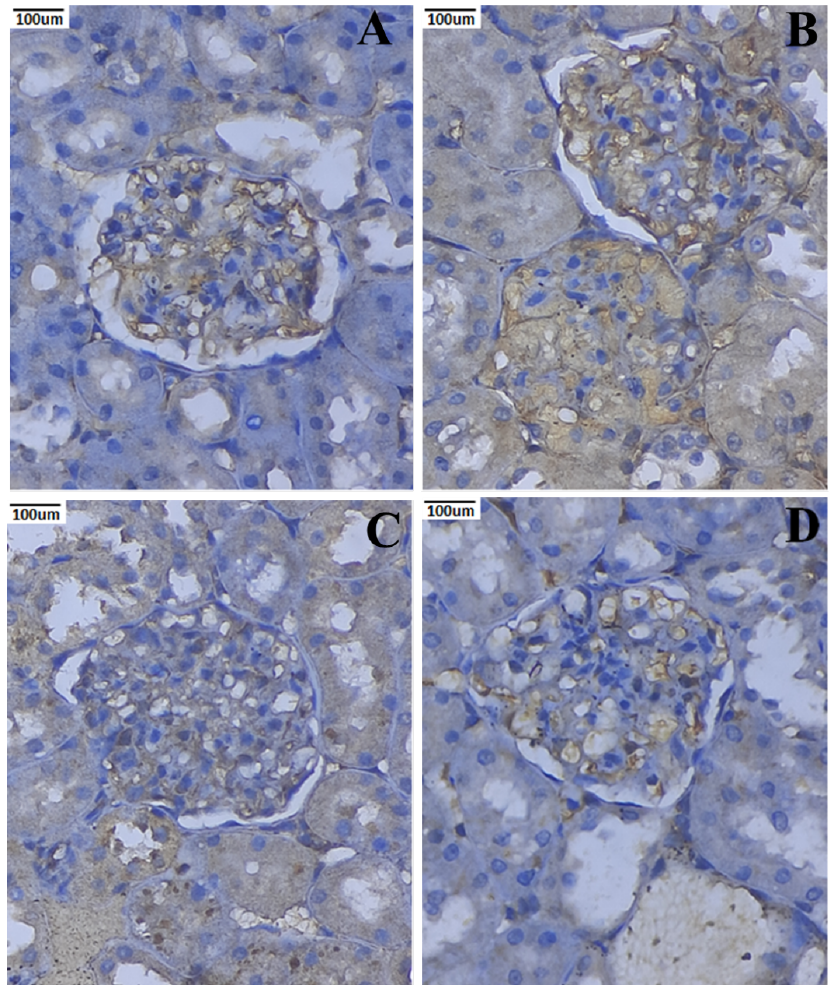
Figure 12. Activities of PCNPs on kidney IL-6 immunohistochemistry of DN rats (40×). ( A ) Control kidney shows a normal expression of glomerulus; ( B ) DN kidney indicates increased expression of IL-6, showing that there is an increased mesangial cellularity at the red arrow; ( C ) STZ + 80 mg/kg of PCNP-treated kidney shows the near-normal appearance of mesangial cells and tubules; ( D ) 80 mg/kg of PCNPs only shows the normal expression of IL-6 in mesangial cells.